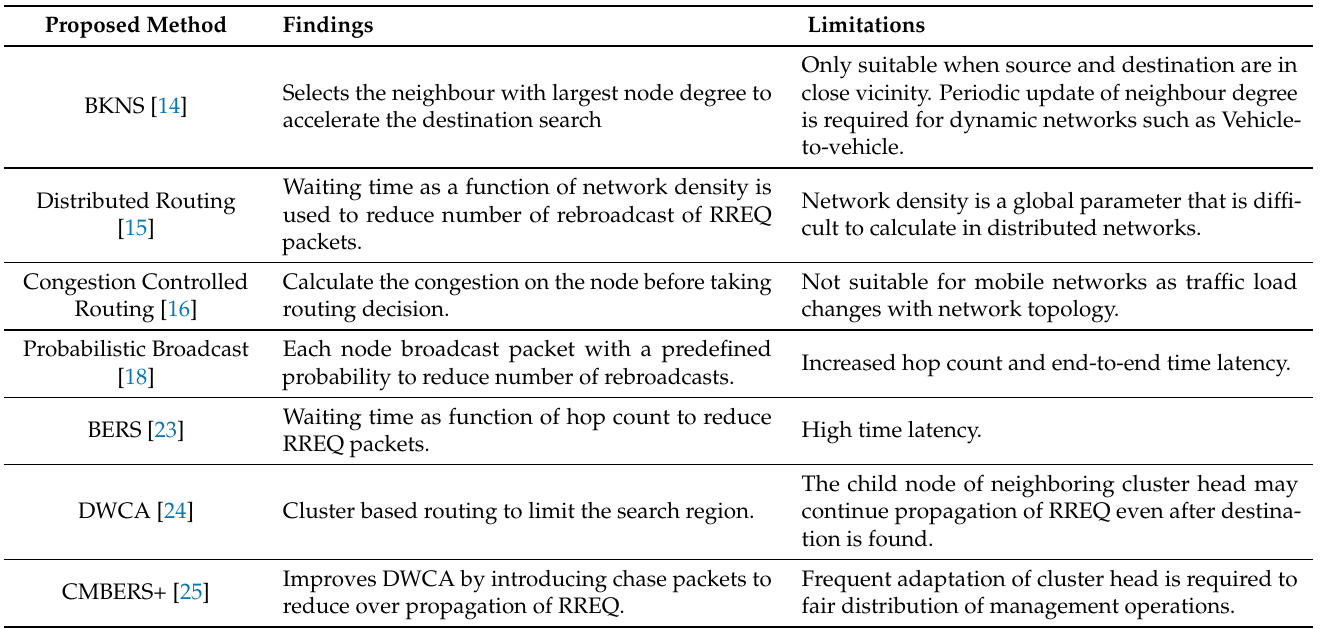
Table 1. Summary of Related